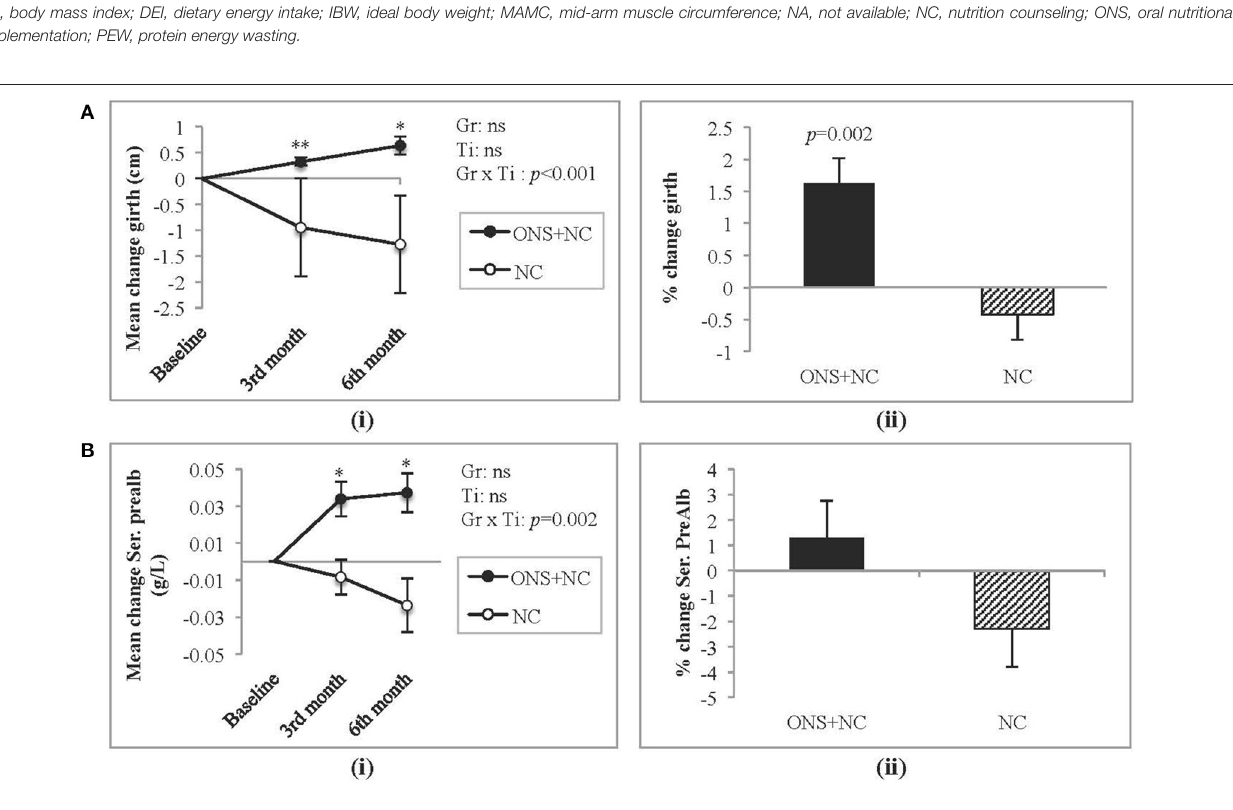
= 0.025) and dietary parameters (mean change for energy intake = 366 ± 60 kcal/day, p < 0.001; mean change for protein intake = 17.4 ± 3.2 g/day, p < 0.001).